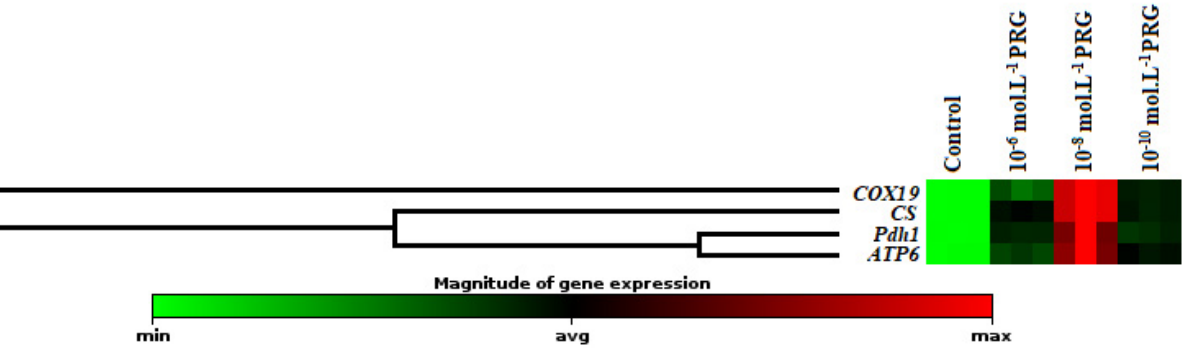
Figure 3. Effect of progesterone on the gene expression of citrate synthase ( CS ), cytochrome oxidase ( COX19 ), pyruvate dehydrogenase ( Pdh1 ), and ATP synthase ( ATP6 ) in the coleoptiles of 4-day-old maize seedlings. The clustergram performs non-supervised hierarchical clustering of the entire dataset to display a heat map with dendrograms indicating co-regulated genes across groups.